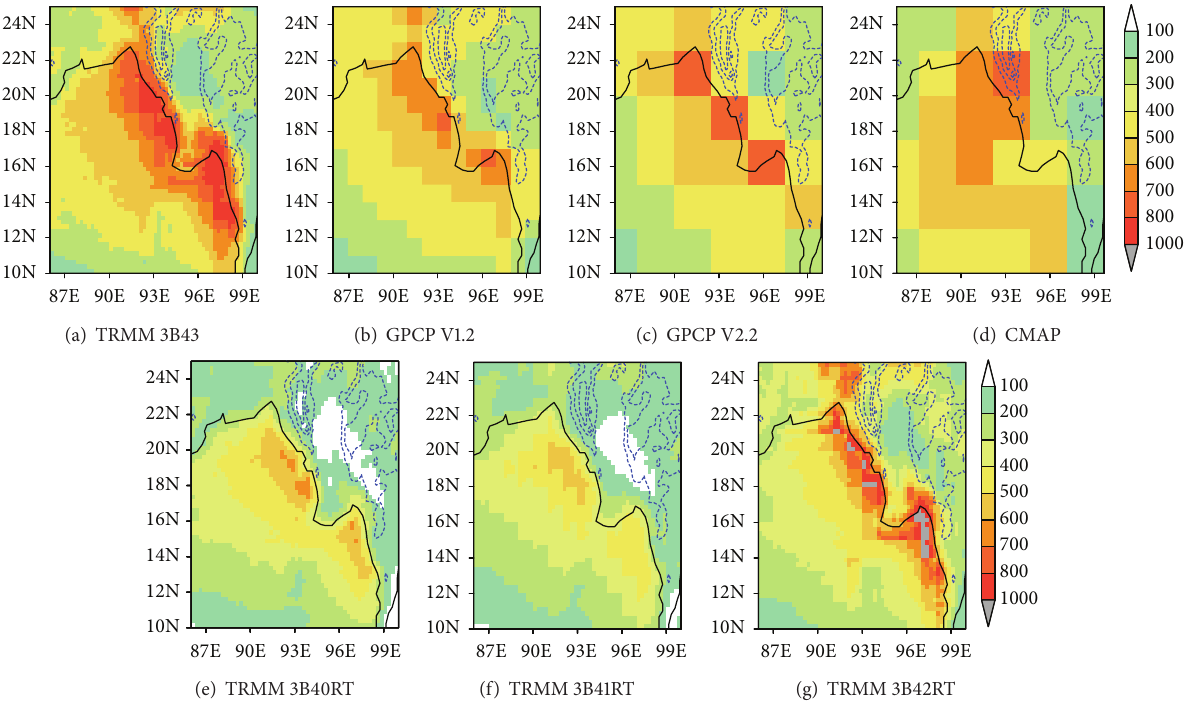
Figure 1: Distribution of climatological JJA mean precipitation (mmmonth −1 ) of the TRMM 3B43 and GCPC V1.2 from 1998 to 2014, GPCP V2.2 and CMAP products from 1979 to 2014, and TRMM 3B40RT, 3B41RT, and 3B42RT products from 2000 to 2014. The blue dotted contours mark the topography at 500 m, 1000 m, and 1500m above the sea